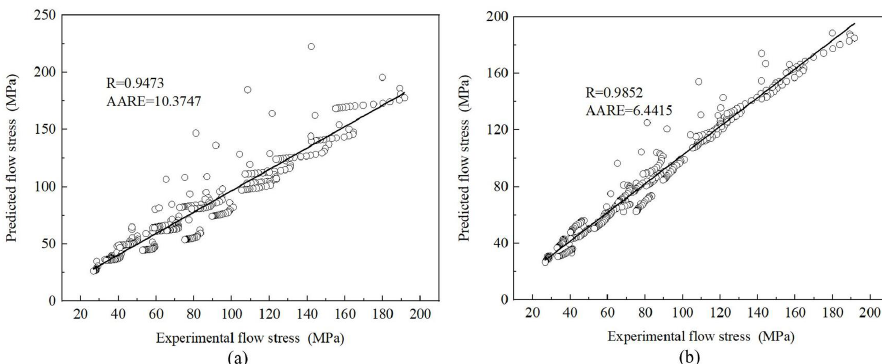
Figure 9. Error analysis of (a) the original Johnson-Cook model and (b)modified Johnson-Cook